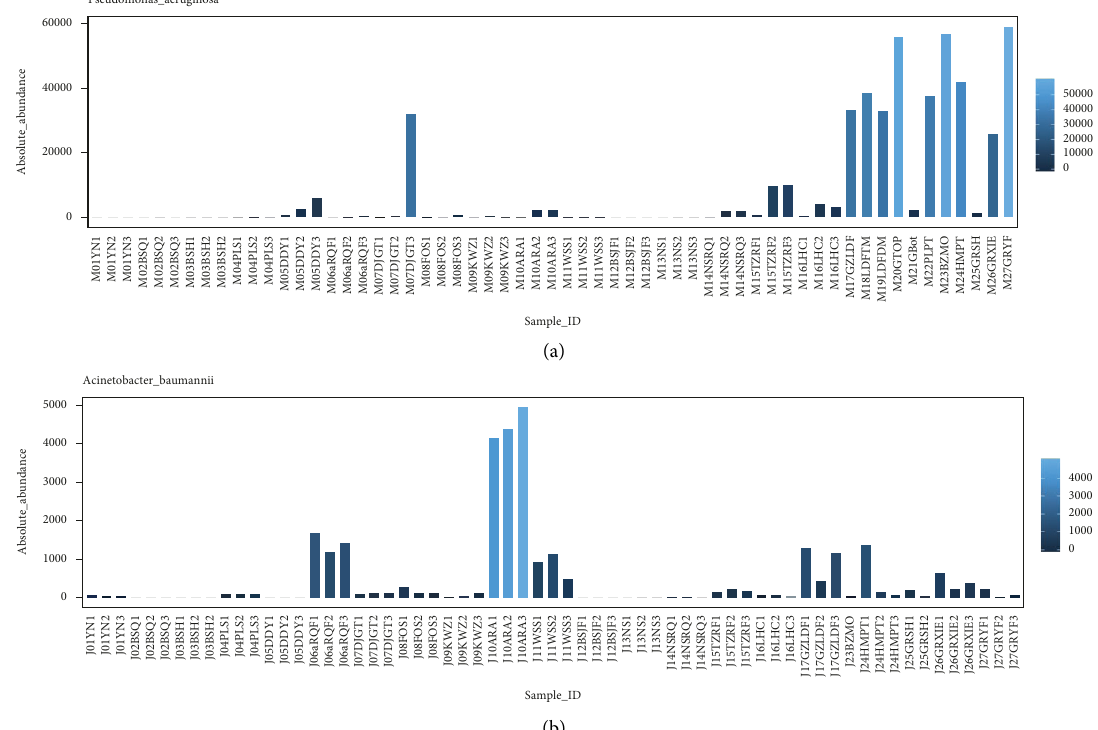
Figure 5: Number of feature sequences classified as Pseudomonas aeruginosa in spring samples (a) and Acinetobacter baumannii in summer samples (b) of the infant milk formula production